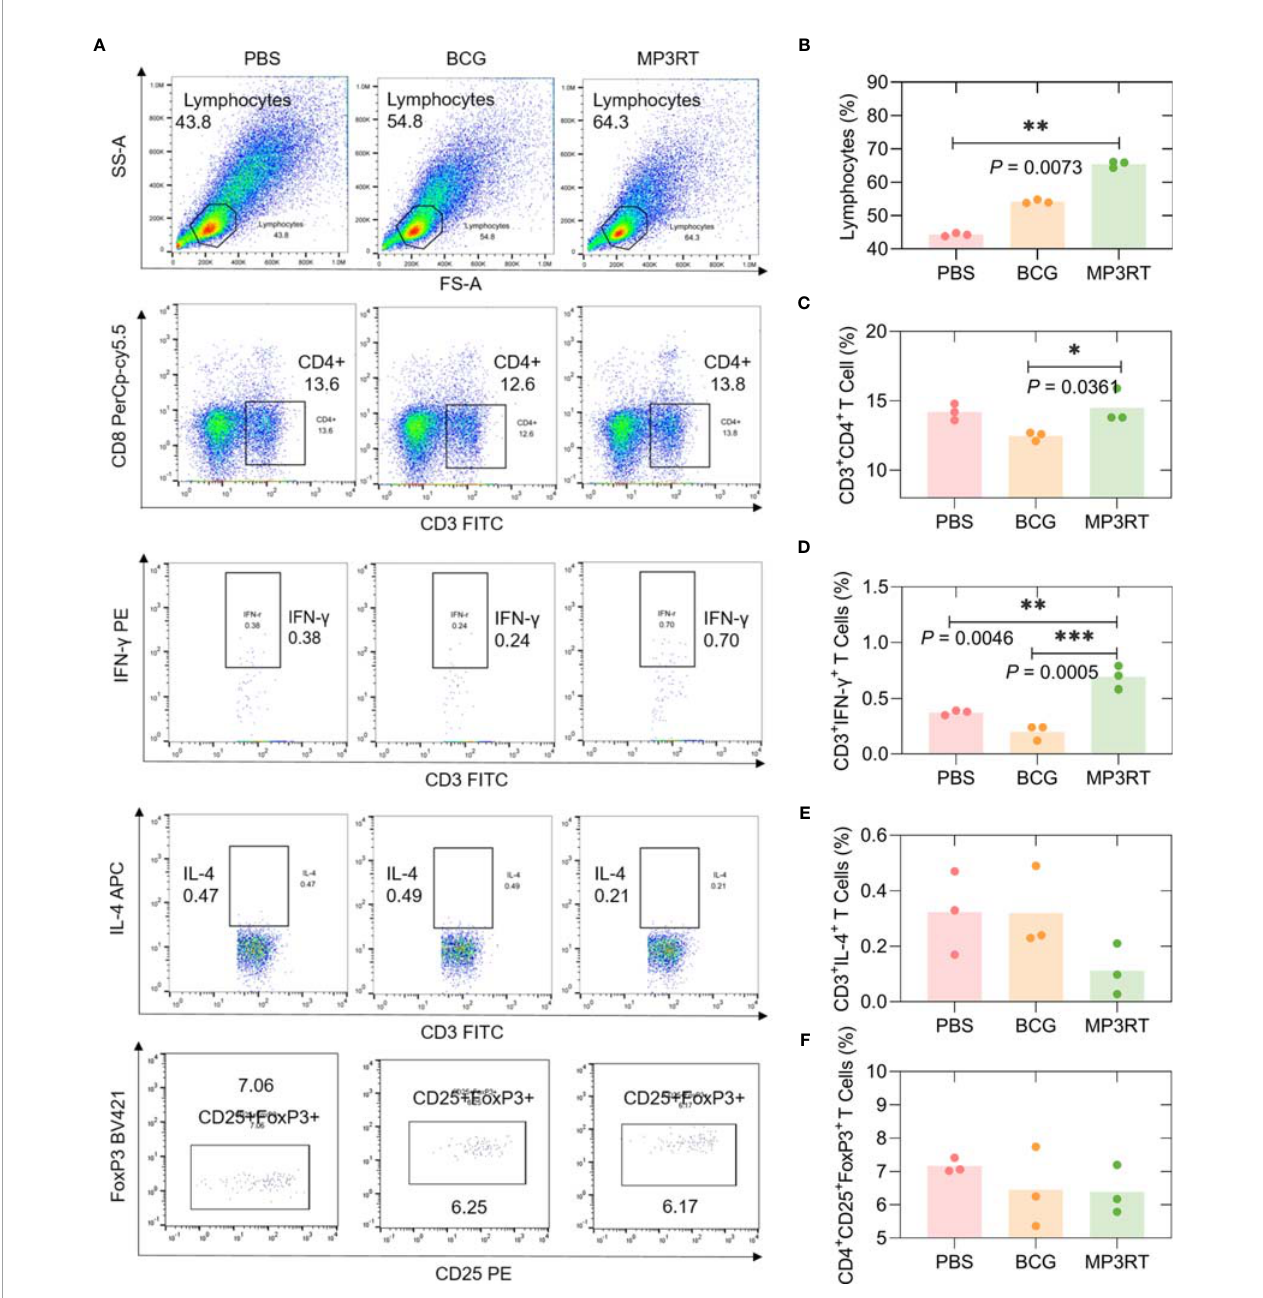
FIGURE 8 | The frequency of lymphocytes, CD3 + CD4 + T cells, CD3 + IFN- g + T cells, CD3 + IL-4 + T cells, and CD4 + CD25 + FoxP3 + Treg T cells in humanized mice. The splenocytes suspension was prepared, and the frequency of lymphocytes (A, B) , CD3 + CD4 + T cells (A, C) , CD3 + IFN- g + T cells (A, D) , CD3 + IL-4 + T cells (A, E) , and CD4 + CD25 + FoxP3 + regulatory T cells (A, F) was quanti fi ed with a BD IntraSure ™ kit. The differences in the frequency of cells among PBS, BCG, and MP3RT groups were analyzed with the one-way analysis of variance (ANOVA) or Kruskal-Wallis test according to the data normality homogeneity of variances. All data were shown as mean + SEM ( n = 3). P < 0.05 was considered signi fi cantly different. * P < 0.05; ** P < 0.01; *** P <